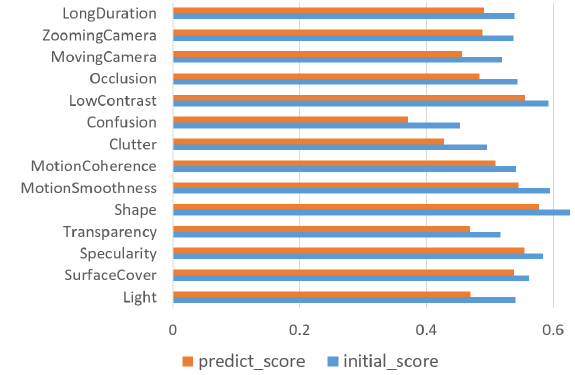
Figure 6. The predict and initial score in different situations.